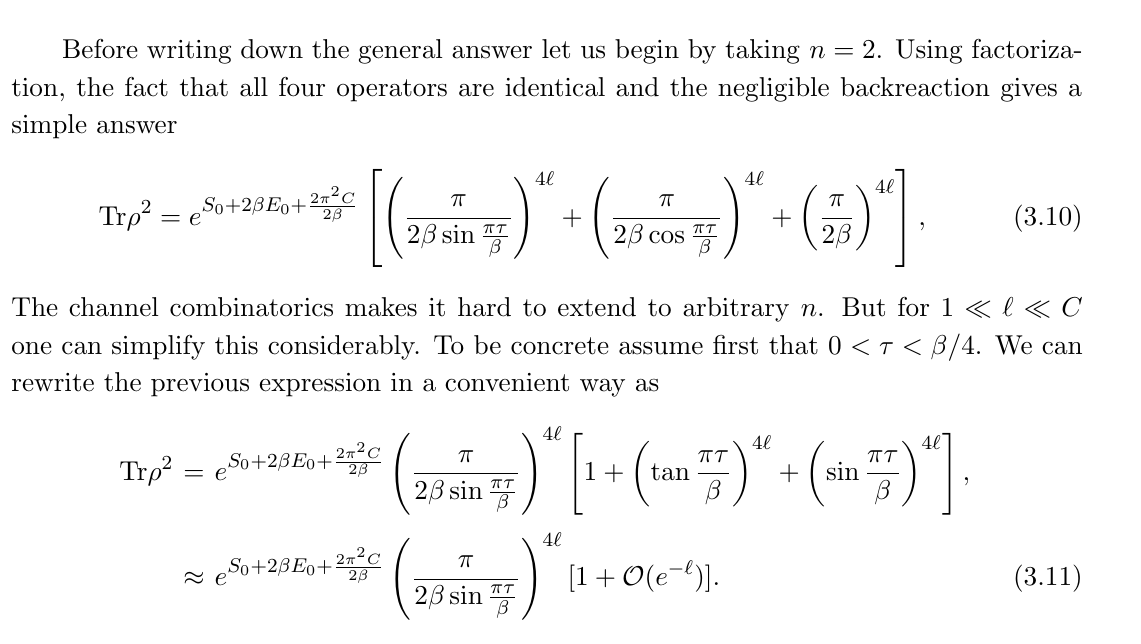
Figure 7 . Replica Geometry for 1 (cid:28) ‘ (cid:28) C with n = 4. We indicate the channel that dominates when 0 < (cid:28) < (cid:12)= 4 (left) and (cid:12)= 4 < (cid:28) < (cid:12)= 2 (right). The central black dot indicates the Z n symmetric horizon with minimal